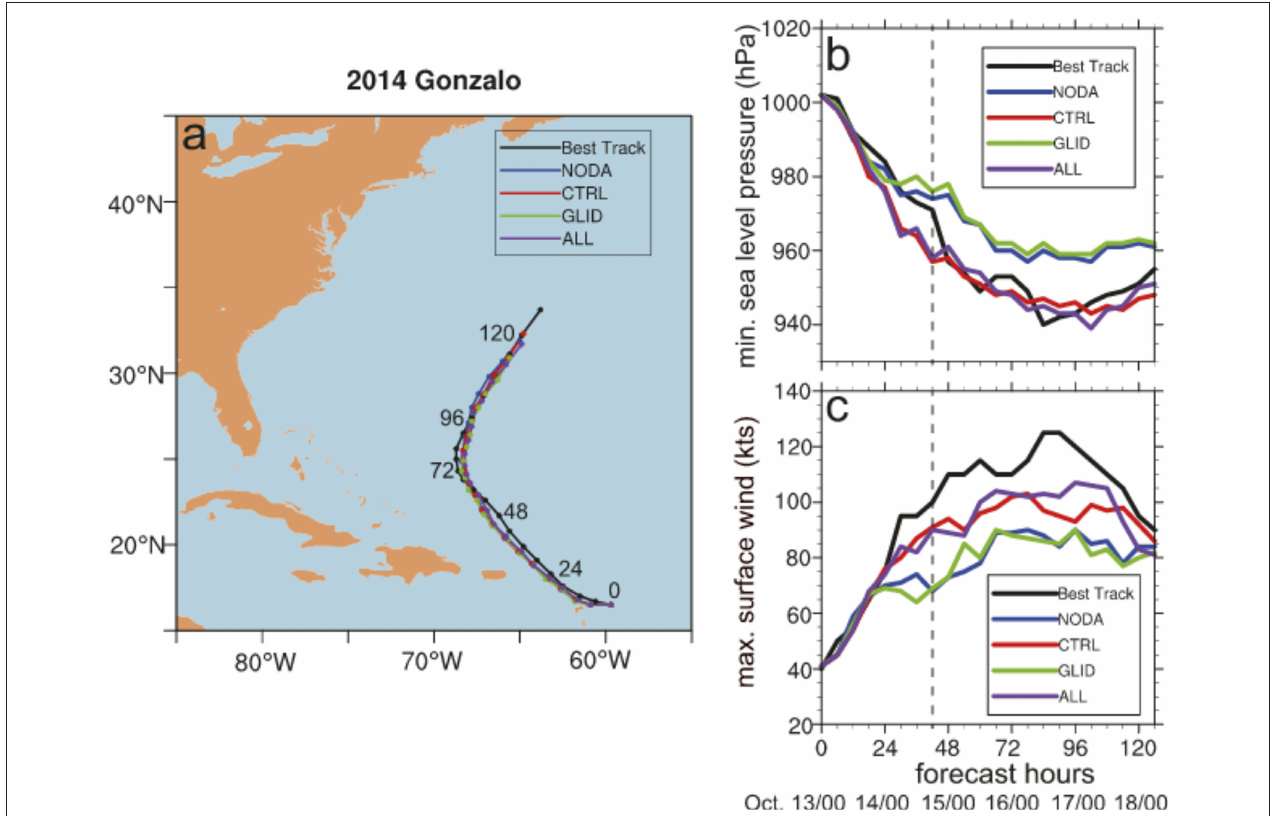
FIGURE 7 | (a) Hurricane Gonzalo track forecast, (b) minimum sea level pressure (center pressure), and (c) maximum wind forecasts, along with the best track. Gliders improve hurricane forecast. The dashed line denotes the track location closest to the glider at 0000 UTC 13 Oct 2014. (Figure 12 from Dong et al.,